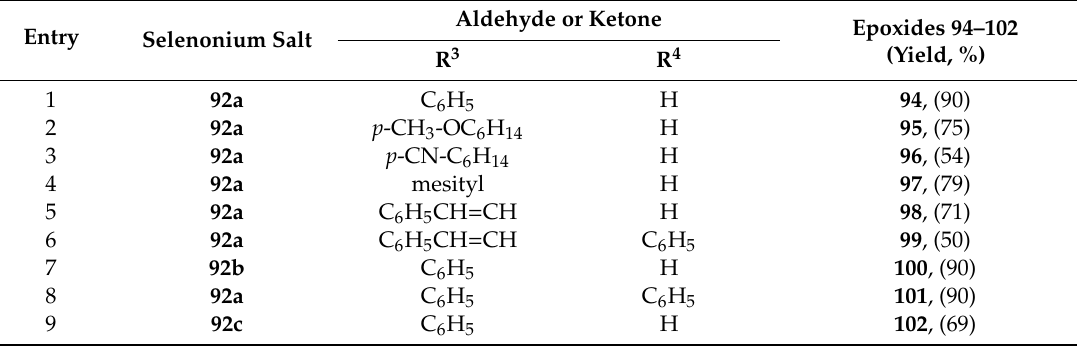
Table 6. Reaction of selenonium salts 92a – c with various aldehydes and